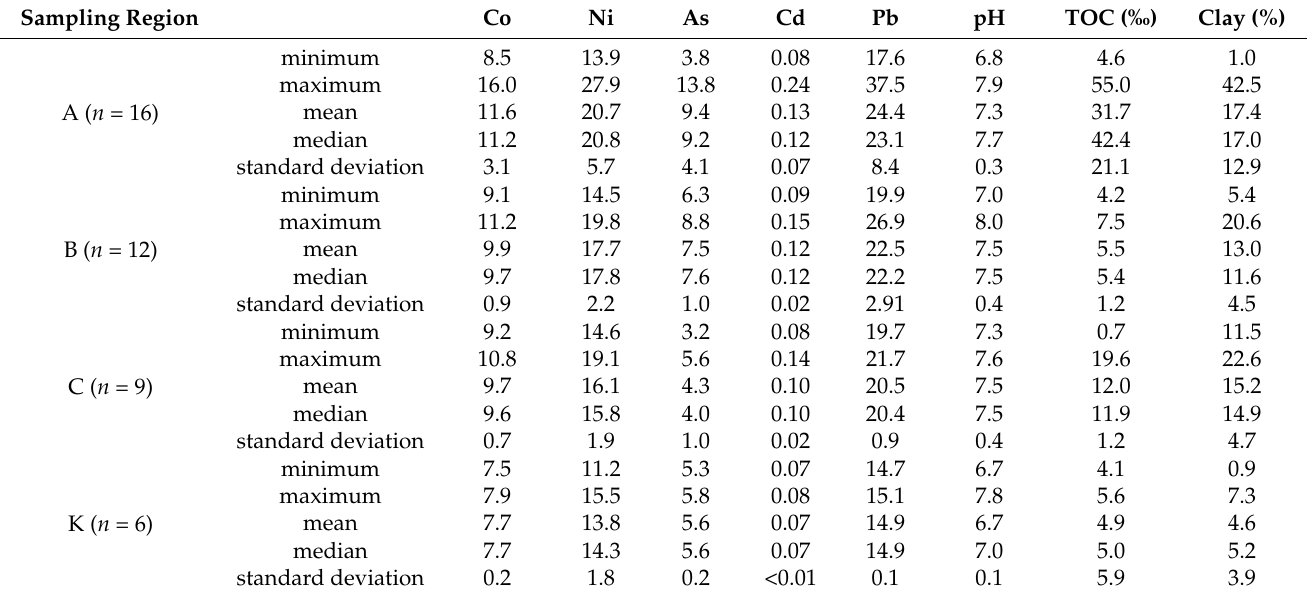
Table 1. Mass fractions (mg/kg) of selected metals in sediments from different wetland swamps in the Yellow River